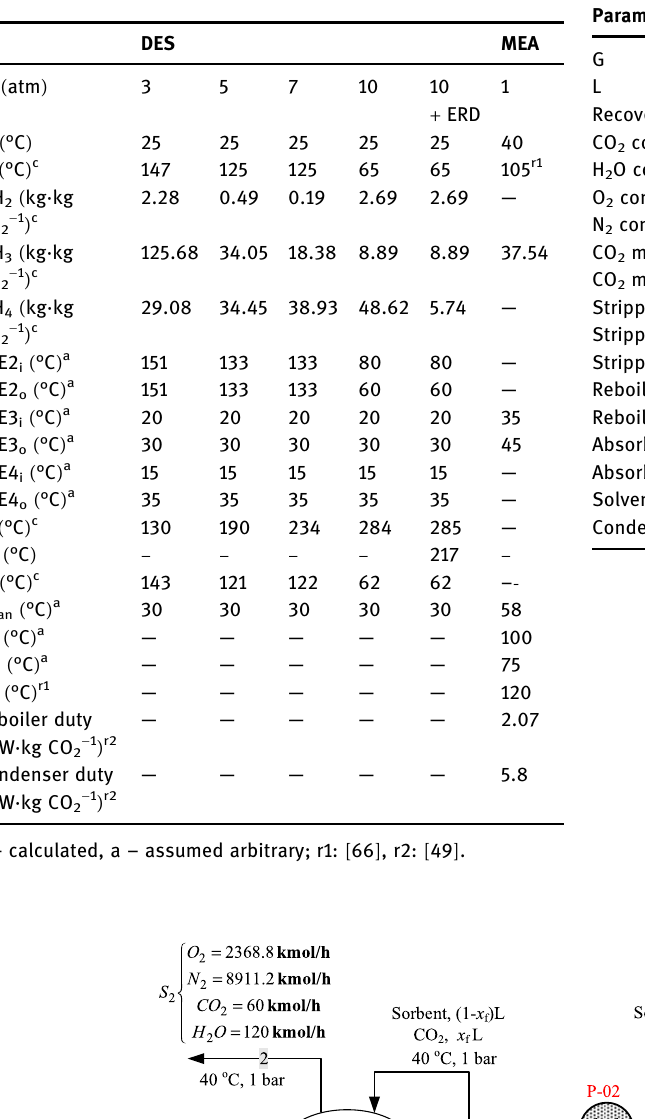
Table A3: Operating conditions for MEA